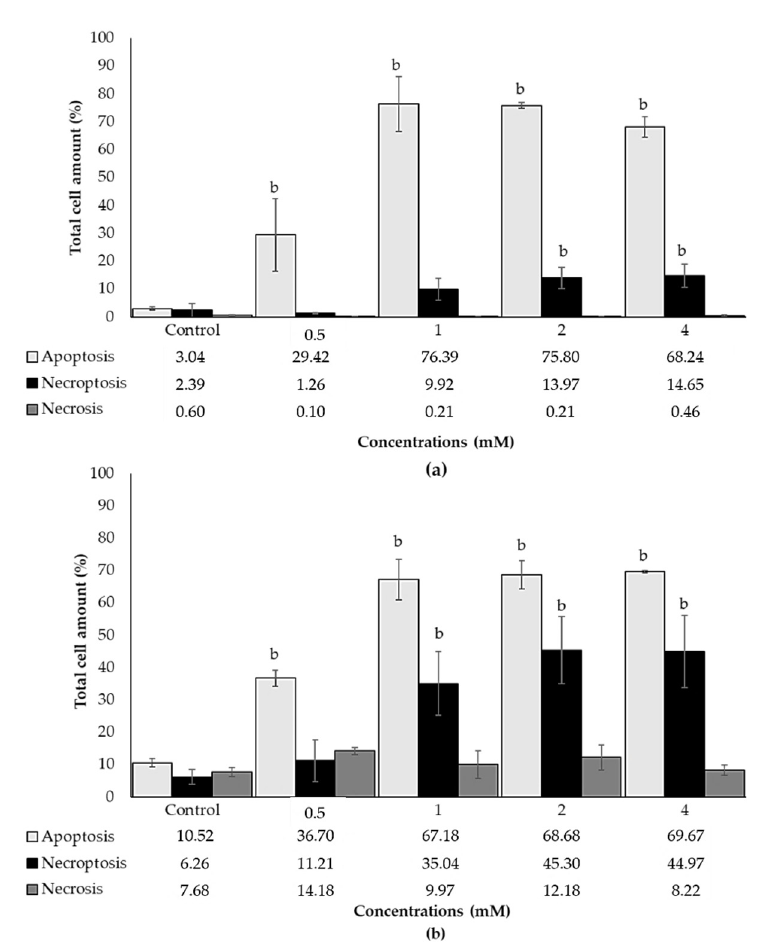
Figure 5. Apoptotic and necrotic effects of ACE measured by ( a ) flow cytometer and ( b ) fluorescent microscopic imaging in SH-SY5Y cells after 24 h of treatment. Apoptotic cells were expressed as the cell population of Annexin V pos /PI neg , necroptotic cells were expressed as the cell population of Annexin V pos /PI pos and necrotic cells were expressed as the cell population of Annexin V neg /PI pos . Data are presented as mean ± SD; and statistically significant changes are indicated as b: p < 0.01.